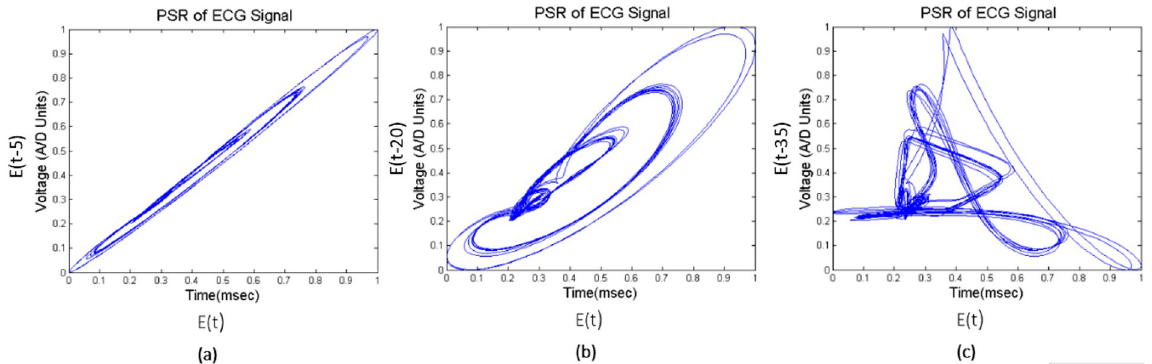
Figure 12. PSR plots with different delay time